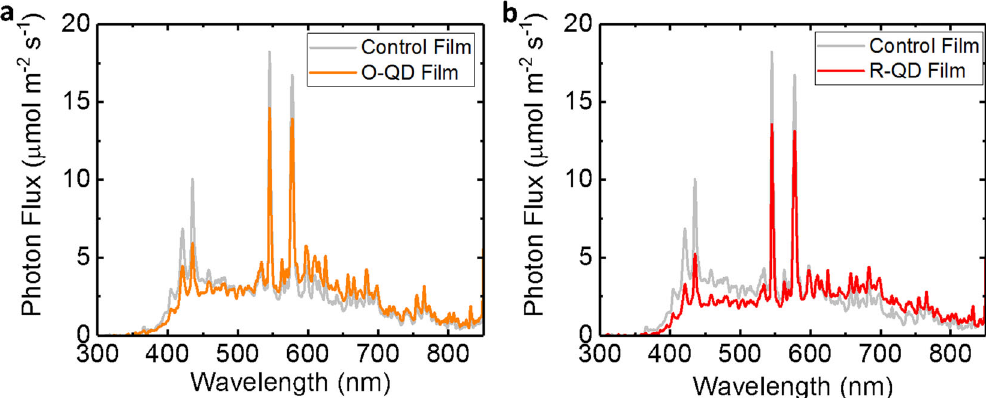
Fig. 2 Measured spectra for each of the three light treatments. a Measured spectra beneath the O-QD fi lm and under the control fi lm. b Measured spectra beneath the R-QD fi lm and control fi